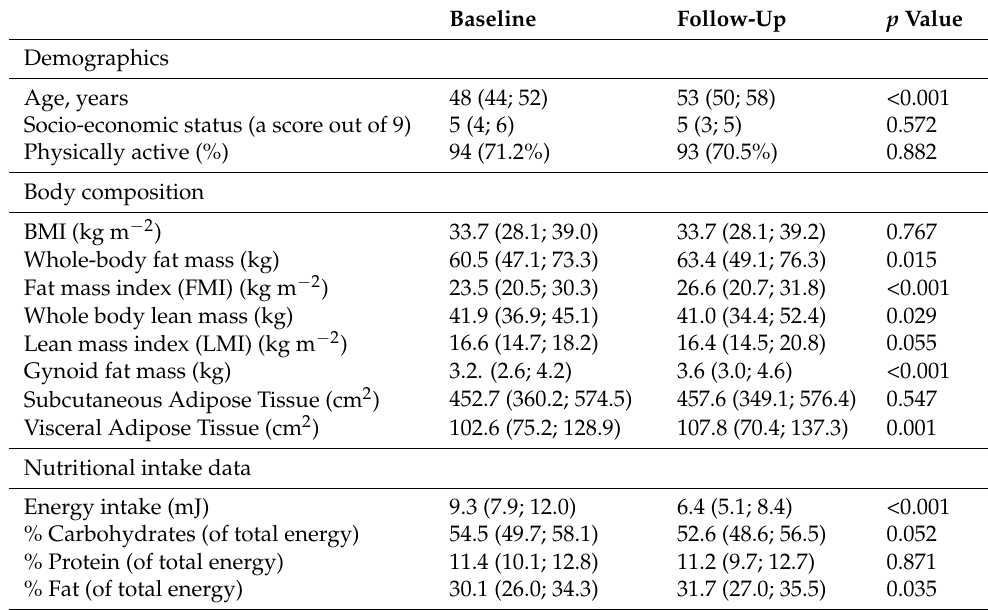
Table 1. Baseline and follow-up descriptive characteristics ( n =